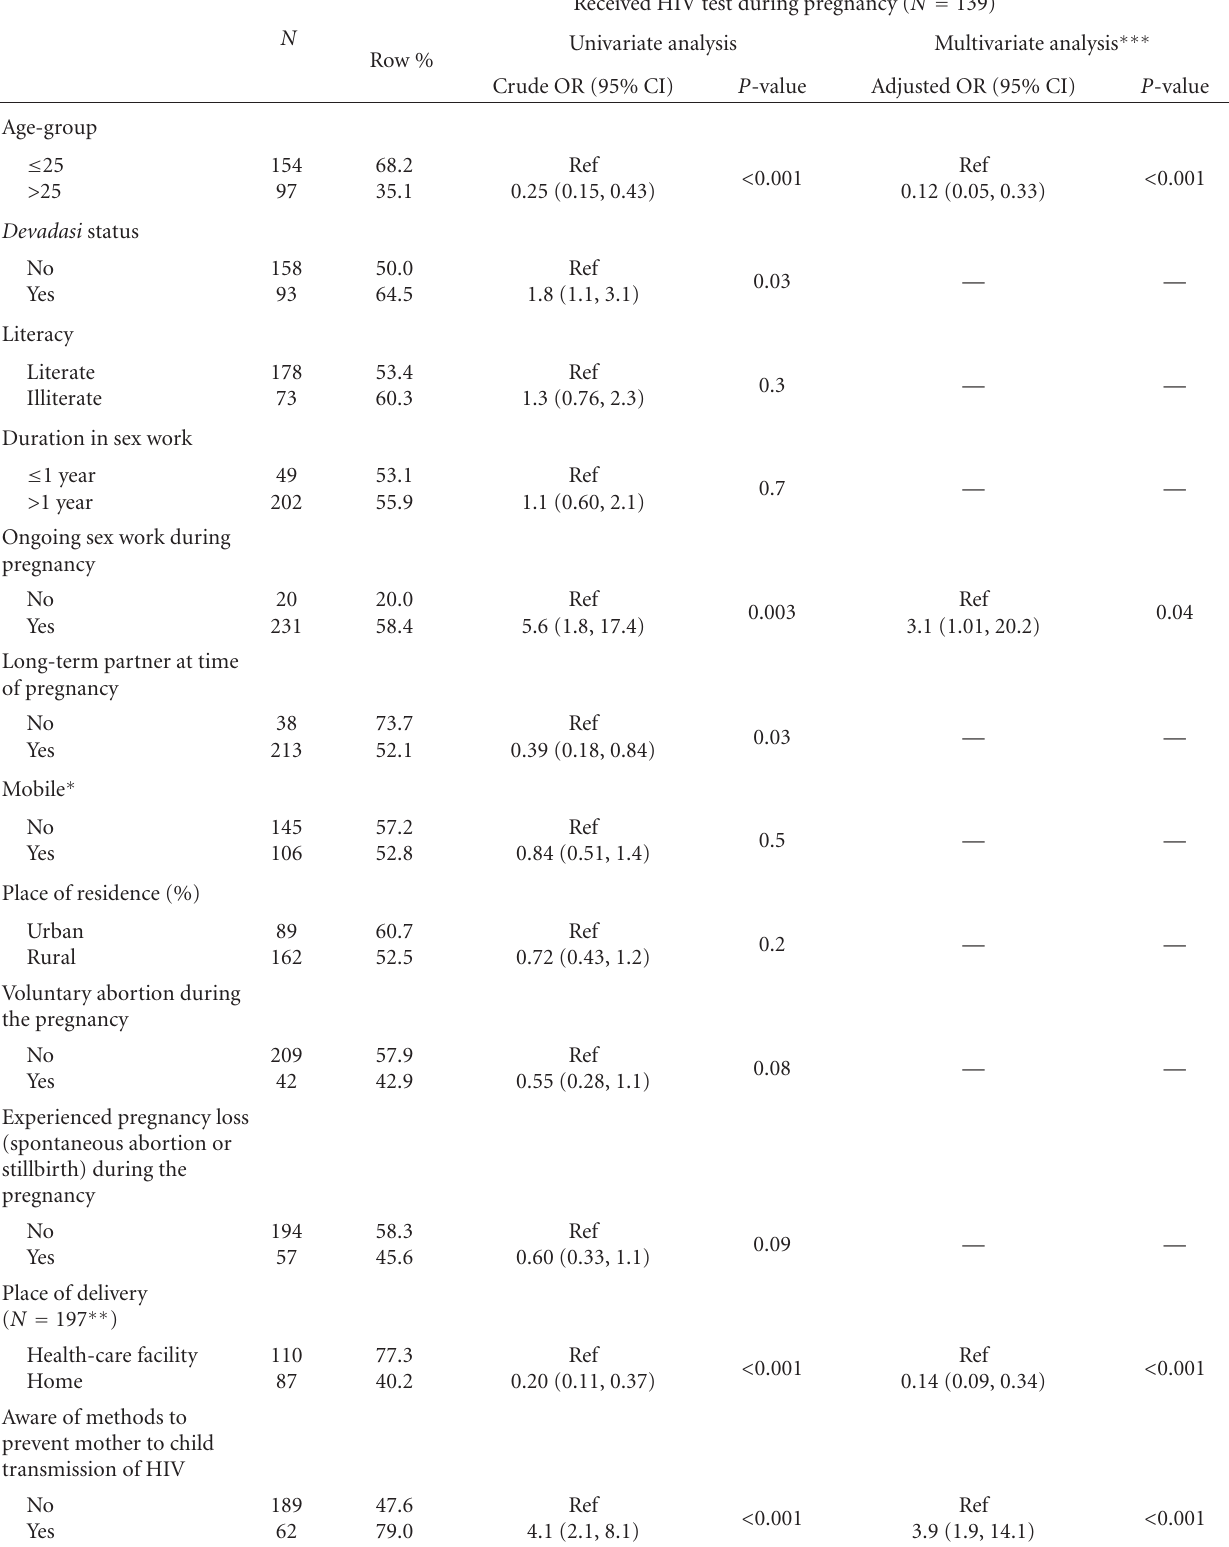
Table 3: Factors associated with HIV testing during pregnancy, among primiparous female sex workers ( N =